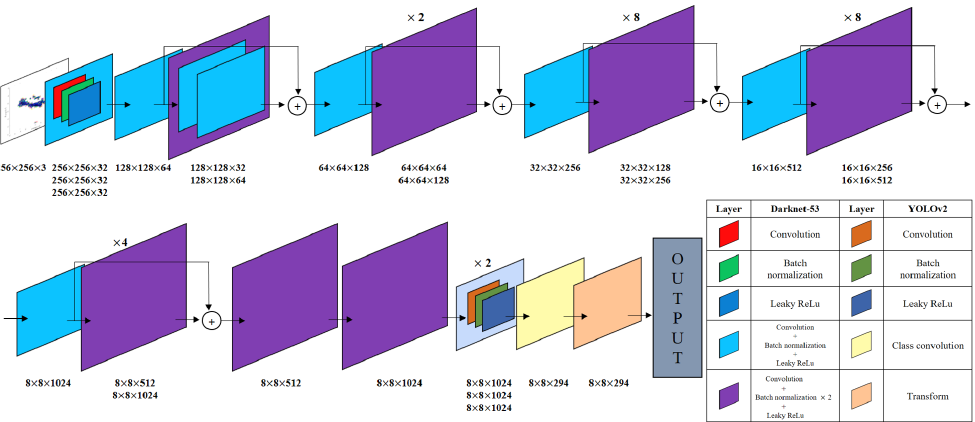
Figure 7. Proposed network for the target classification and moving direction estimation.